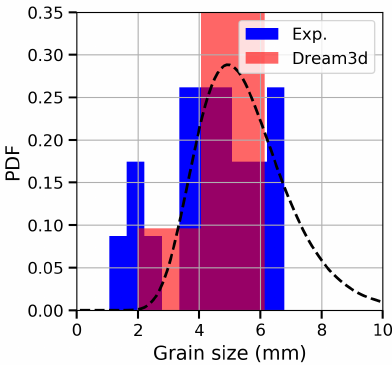
Figure 2. Experimental grain-size distribution (blue histogram) and the log-normal fitting (dashed line) of the alloy. The mean size is 5.5 mm. The virtual grain-size distribution generated with Dream3D [29] is also represented.